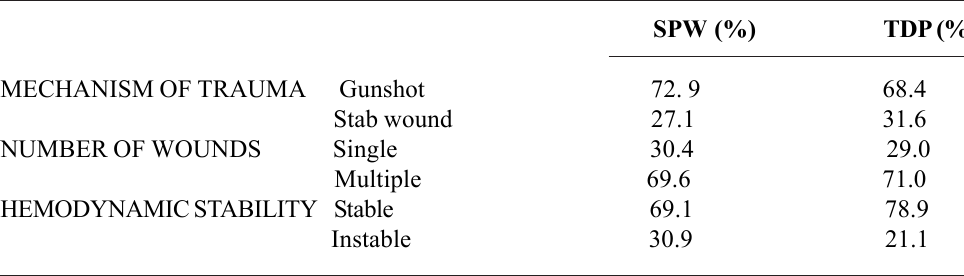
TABLE 1 - Characteristics of the SPW and TDP